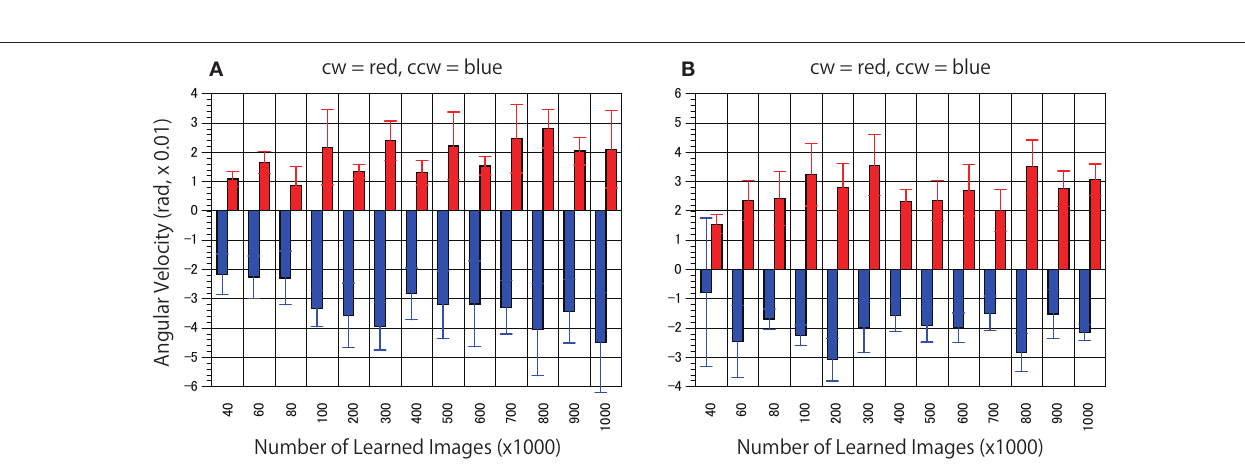
the Lucas-Kanade method (Lucas and Kanade, 1981) using a customized Python program (https://doi.org/10.6084/m9. figshare.5483716.v1, window size 50, quality level 0.3). The rotation center of the propeller was calculated from the motion picture of the propeller by the ImageJ Java program ( Schneider et al., 2012). The provisional rotation center of the rotating snake illusion was taken as the center of the ring. The coordinates of the calculated optical flow vectors were transformed into the coordinate system of the original videos or the still images, and